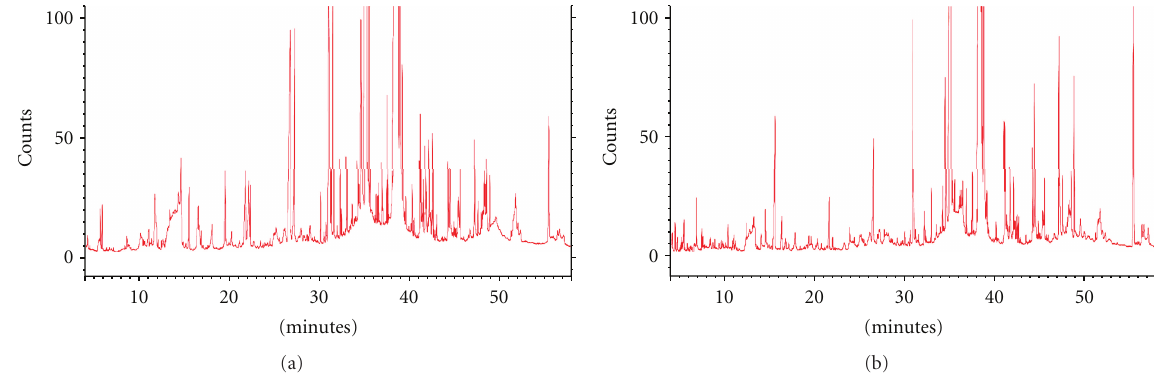
Figure 2: GC chromatograms of the extracts in methanol of the composts C1 (a) and C4 (b). Some of the classes of the functional groups are reported here as a function of the retention time (minutes): up to 20 (cid:6) we have low-molecular-weight ketones, aldehydes, and polyalcohols and at 20 (cid:6) –40 (cid:6) fatty acid and fatty acid esters. It can be seen that the region at low retention times in chromatogram (b) is more crowded than in (a).